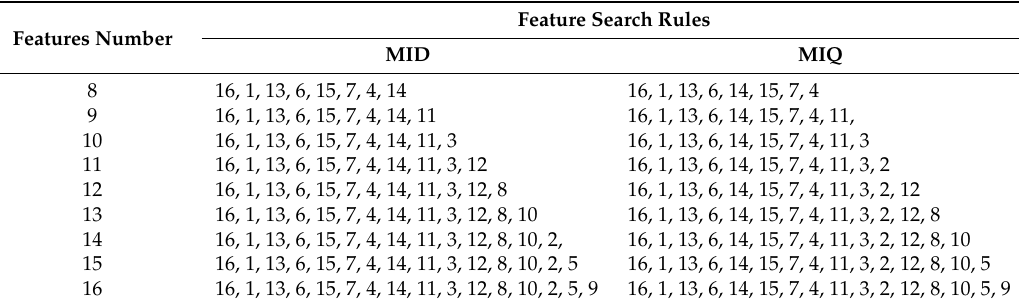
Table 6. Assessment feature subsets in descending order under N class